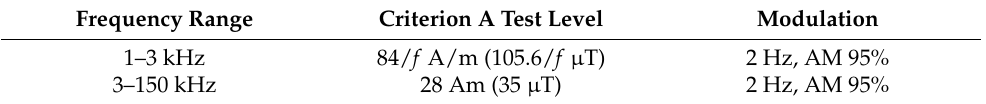
Table 5. Immunity to magnetic fields between 1 kHz and 150 kHz for neurostimulators.